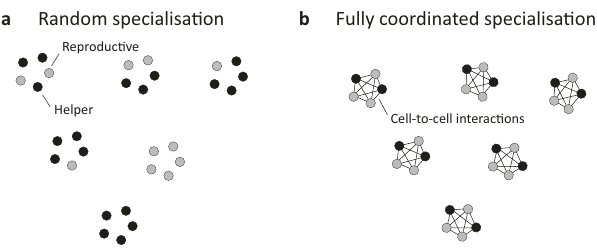
Fig. 2 Mechanisms to produce reproductive division of labour in clonal groups. We examine the relative advantages and disadvantages of the two key mechanisms to produce reproductive division of labour in